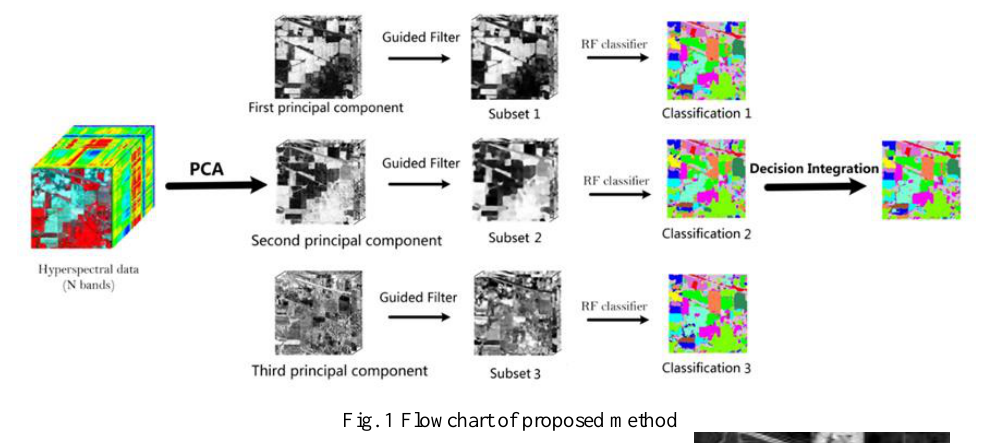
Fig. 1 Flowchart of proposed method